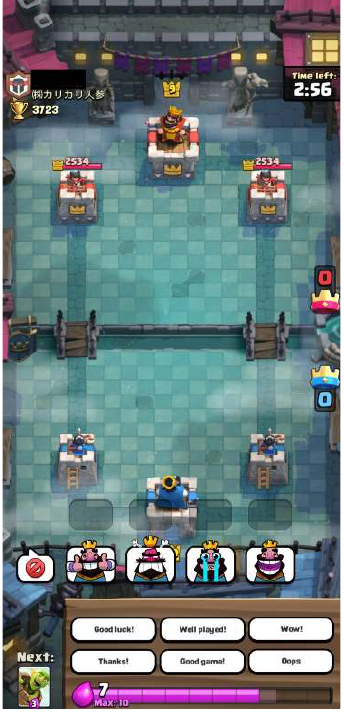
Figure 2: Predefined phrases in Clash